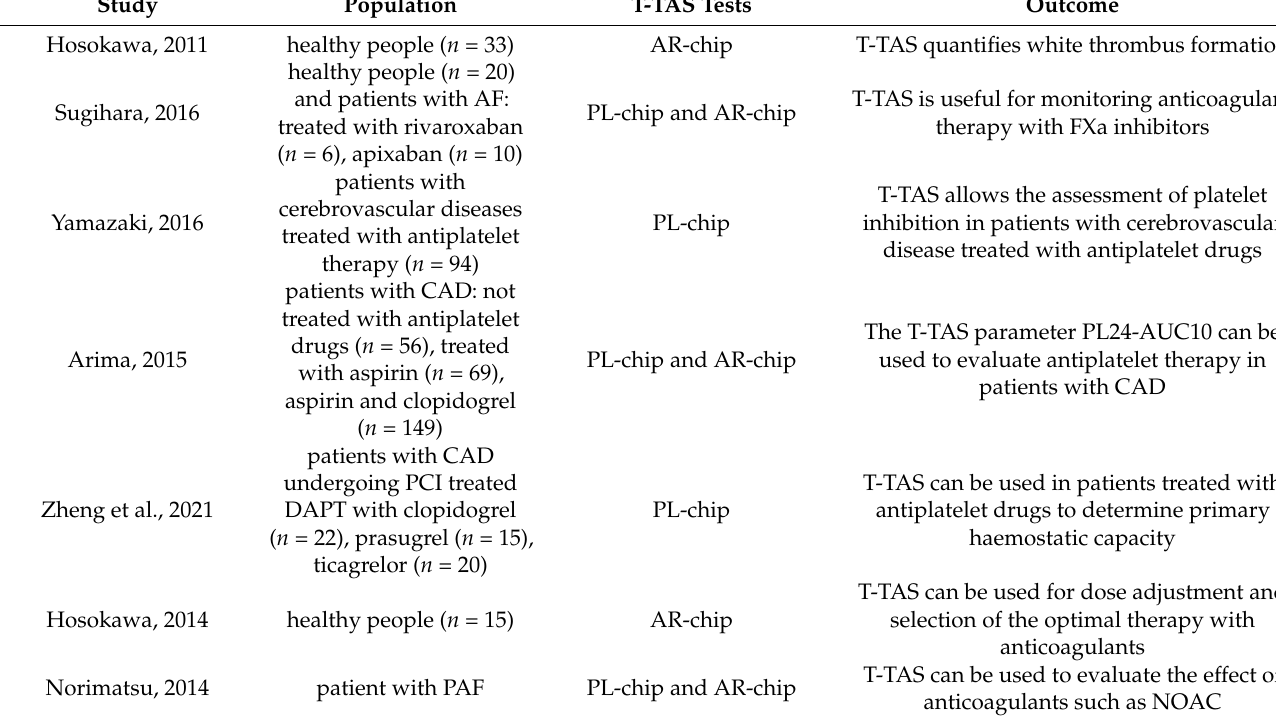
Table 2. Comparison of articles on the topic of monitoring anticoagulant effects (AF—atrial fibrillation, AR10-AUC30—area under the flow pressure curve for the first 30 min for AR-chip tested at flow rate of 10 µ L/min, CAD—coronary artery disease, COMPASS—Cardiovascular Outcomes for People Using Anticoagulation Strategies, DAPT—dual antiplatelet therapy, DOACs—direct oral anticoagulants, FXa—activated blood coagulation factor X, NOAC—novel oral anticoagulants, PAF—paroxysmal AF, PEGASUS—Prevention of Cardiovascular Events in Patients with Prior Heart Attack Using Ticagrelor Compared to Placebo on a Background of Aspirin, PL24-AUC10—area under the flow pressure curve for the first 10 min for PL-chip tested at flow rate of 24 µ L/min, RFCA—radiofrequency catheter